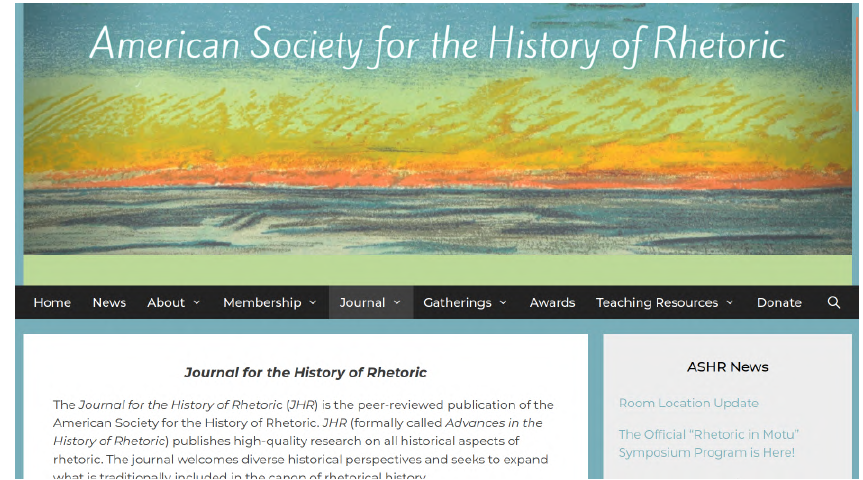
Figure 3: Resource of the American Society for the History of Rhetoric.